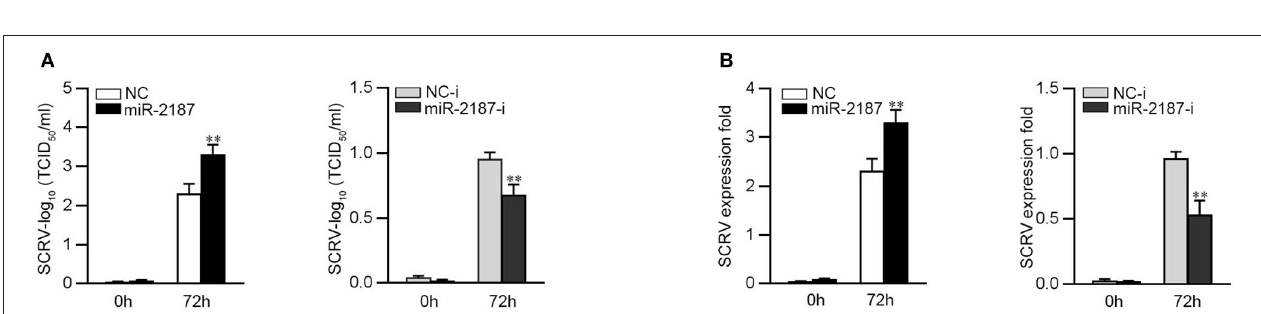
FIGURE 7 | miR-2187 promotes SCRV replication. (A) MKC cells were transfected with NC, miR-2187 mimics, NC-i or miR-2187-i, and infected with SCRV at MOI 5 for 1h and washed and then added with fresh medium. After 72h, SCRV TCID 50 in cultural supernatants was measured with EPC cells. (B) The qRT-PCR analysis was conducted for intracellular SCRV RNA. All data are presented as the means ± SE from at least three independent triplicated experiments. ** p < 0.01 vs. the controls.